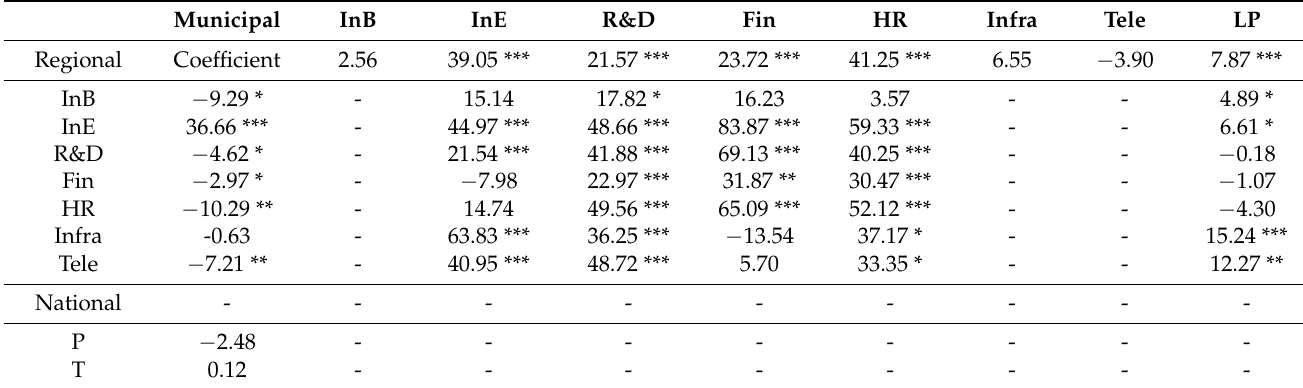
Table 5. The multilevel analysis results of individual innovation.